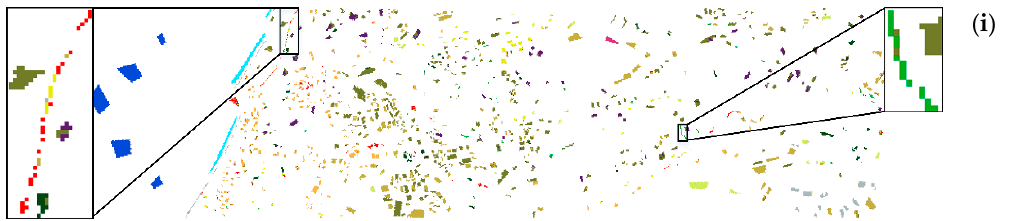
Figure 6. Classi fi cation results of di ff erent algorithms on the HL dataset: ( a ) ground truth; ( b ) 2D-